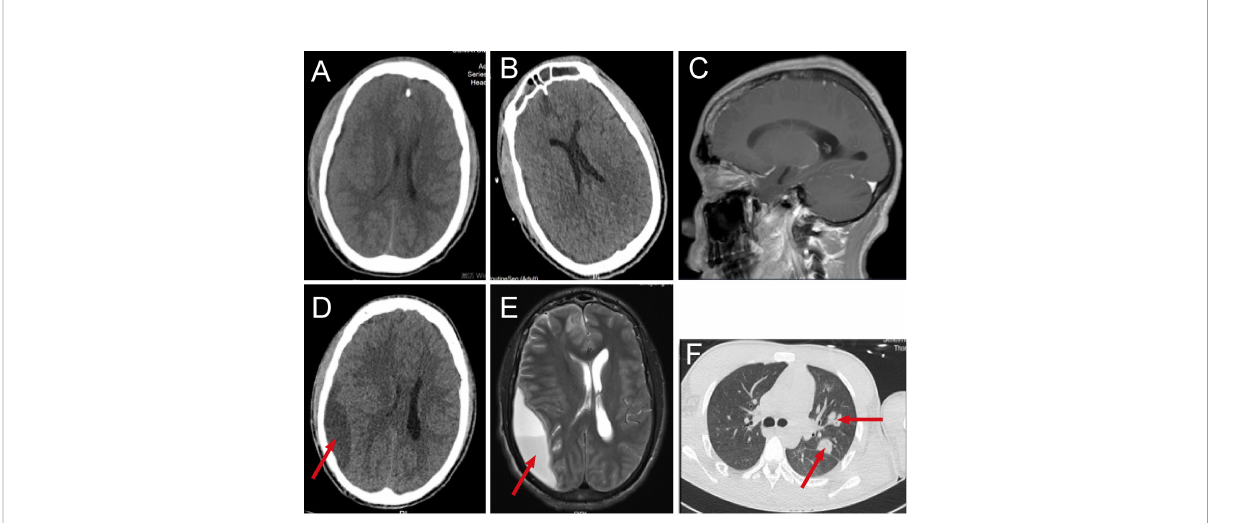
FIGURE 1 The dynamic imaging examination in the pre-operative period. Head computed tomography(CT) scan at admission (A) , head CT on the 7th day of hospitalization (B) , the patient ’ s dental status on magnetic resonance imaging (MRI) (C) , head CT on the 18th day of hospitalization (D) , head MRI on the 21th day of hospitalization (E) , lung CT on the 18th day of hospitalization (F)